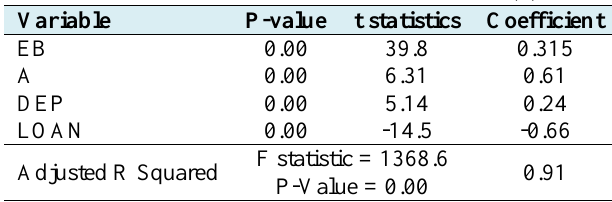
Table 3. Estimation Results of Model